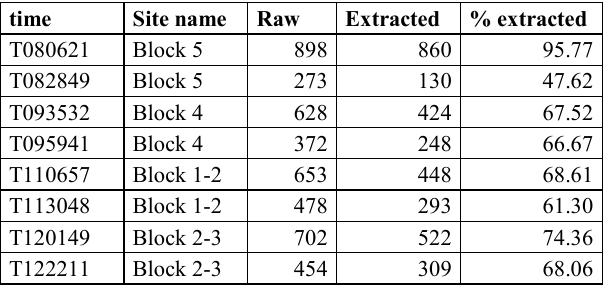
Table 3. % of images extracted from the Slantrange calibration procedure for Alexander Stream National Park data